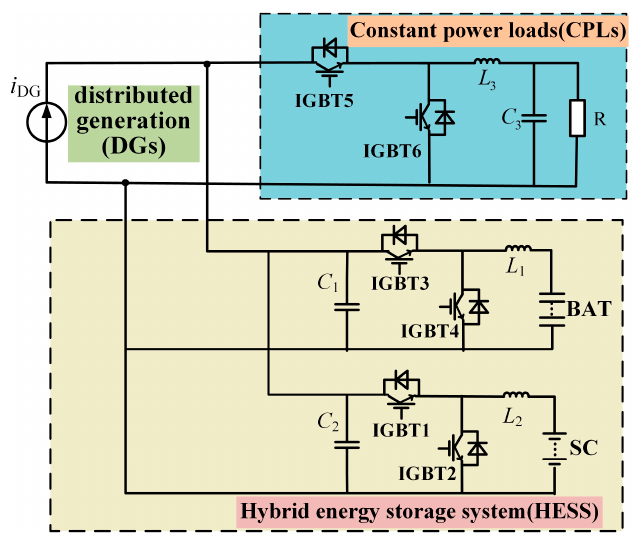
Figure 2. Simplified structure of islanded DC microgrid with HESS, CPLs and DGs.